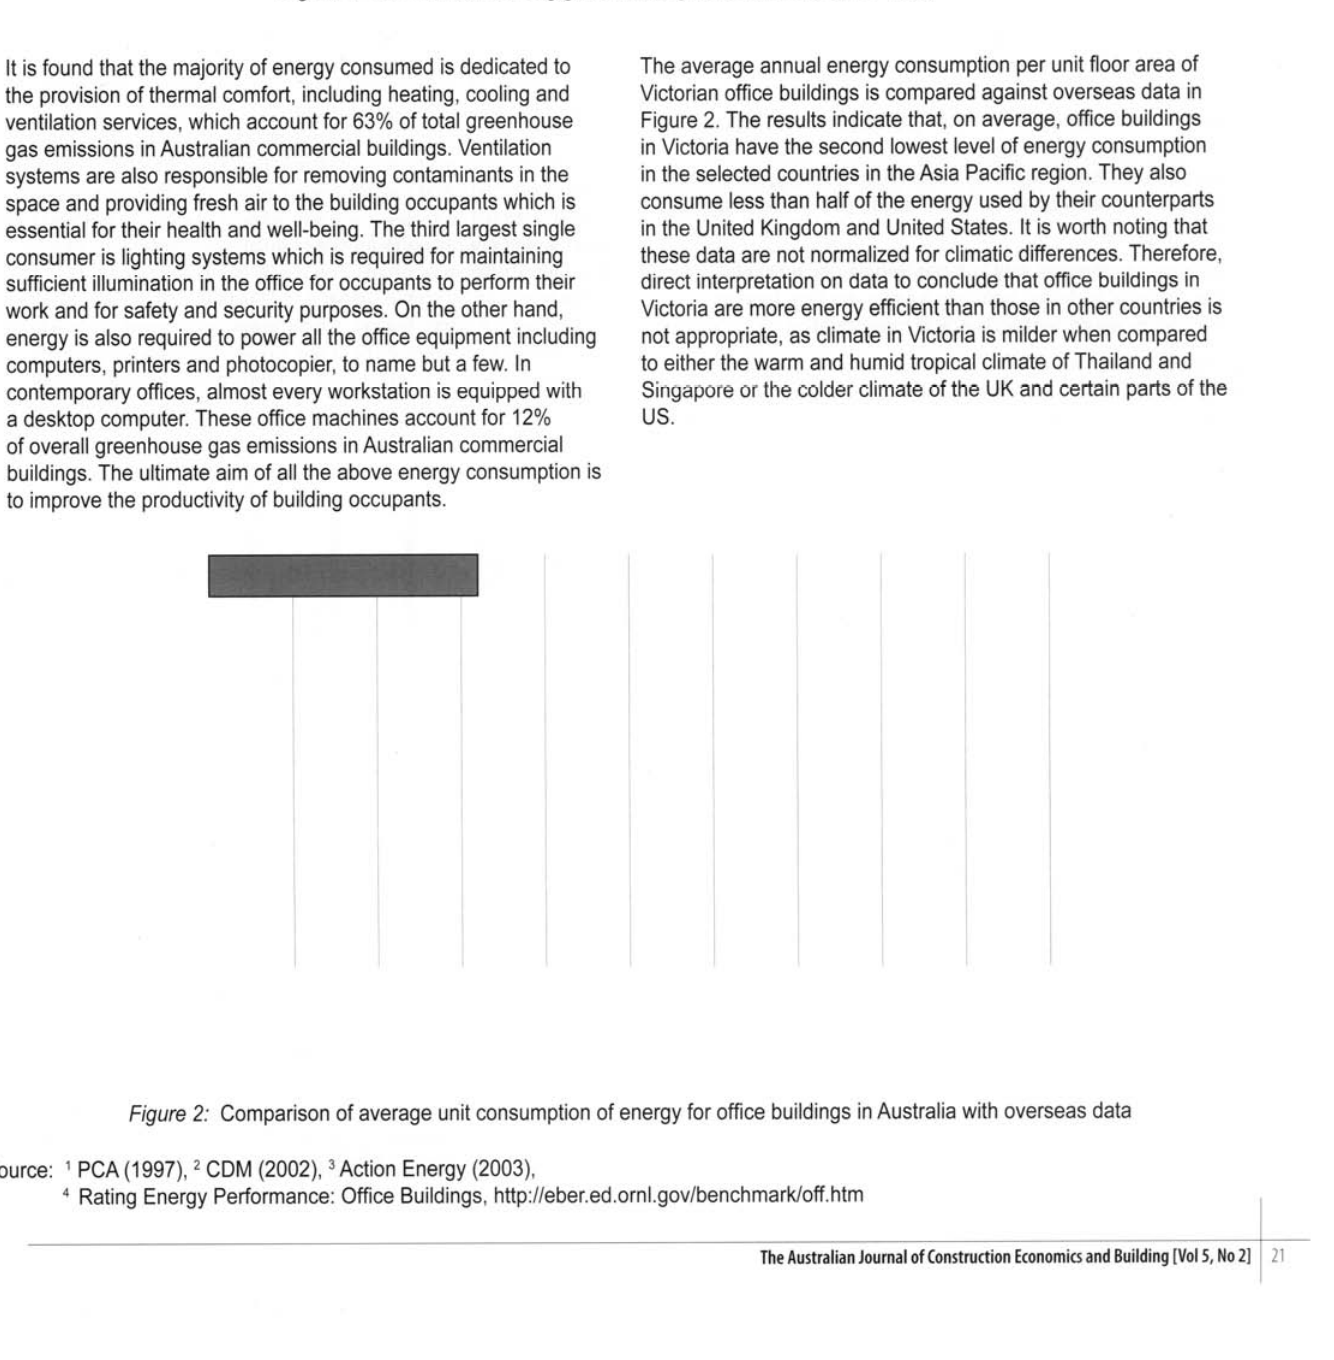
Figure 2: Comparison of average unit consumption of energy for office buildings in Australia with overseas data Source: 1 PCA (1997), 2 CDM (2002), 3 Action Energy